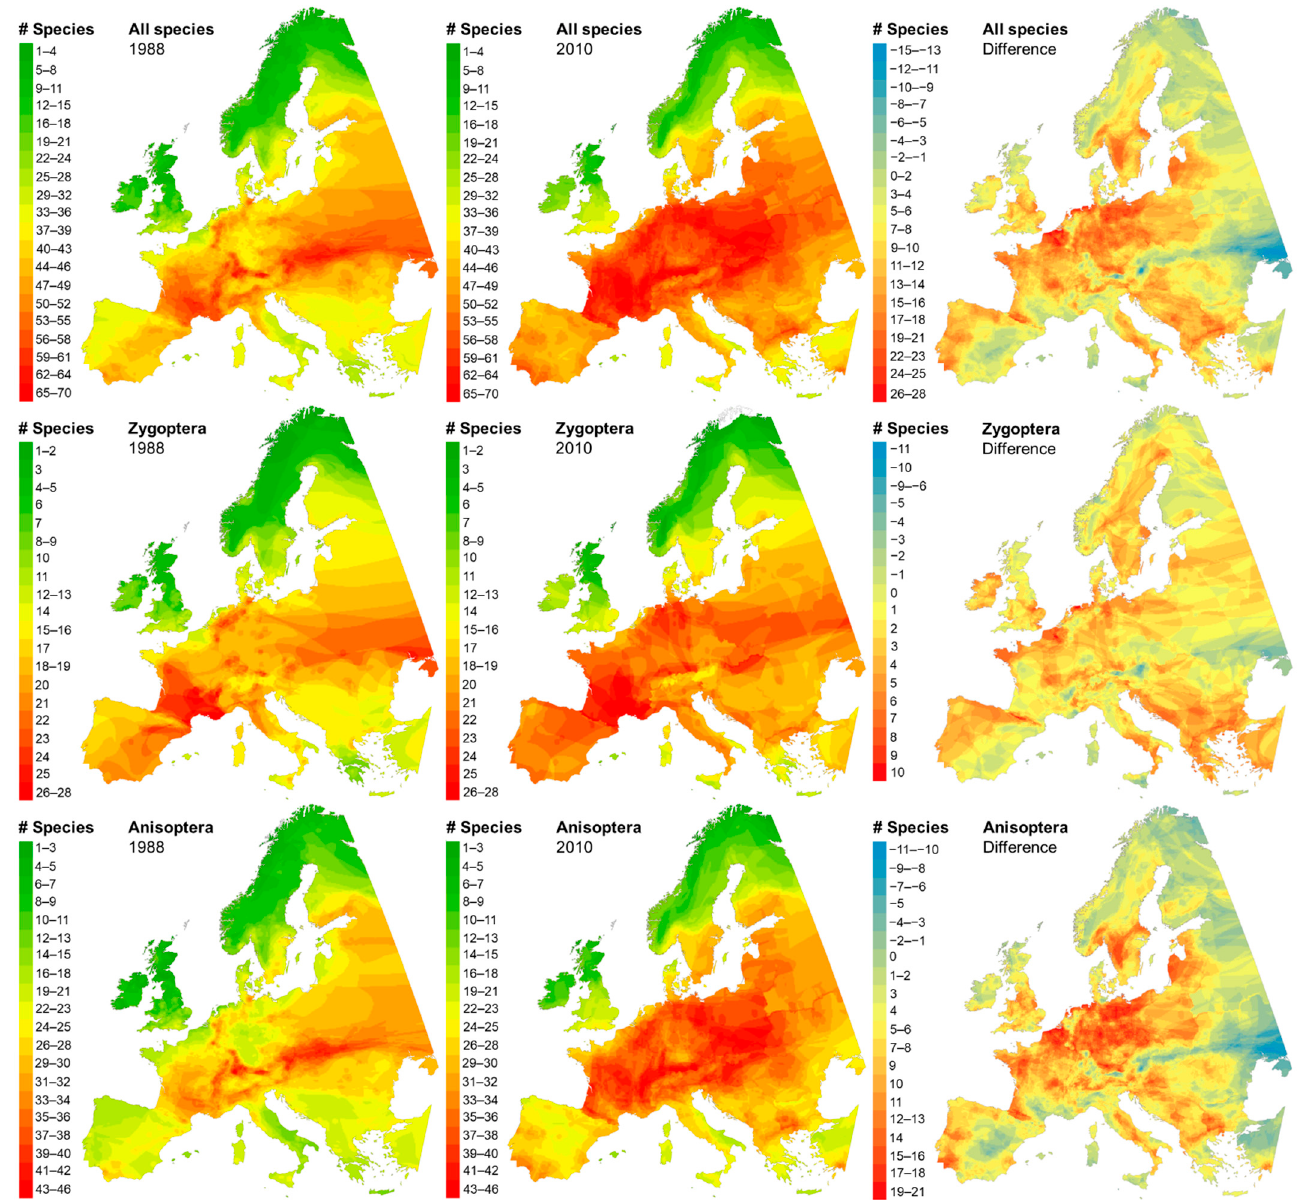
Figure 4. Geographical patterns of European dragonfly (Odonata) species richness and changes by taxonomic suborder. Observed species richness in 1988 according to Askew [49] (left column), observed species richness in 2010 according to Kalkman et al. [34] (middle column), and difference in observed species richness between 1988 and 2010 (negative value = decrease, positive value = increase) (right column). European data presented for all species (upper row), damselfly (Zygoptera) species (middle row), and true dragonfly (Anisoptera) species (lower row) at 10 km × 10 km grid resolution.